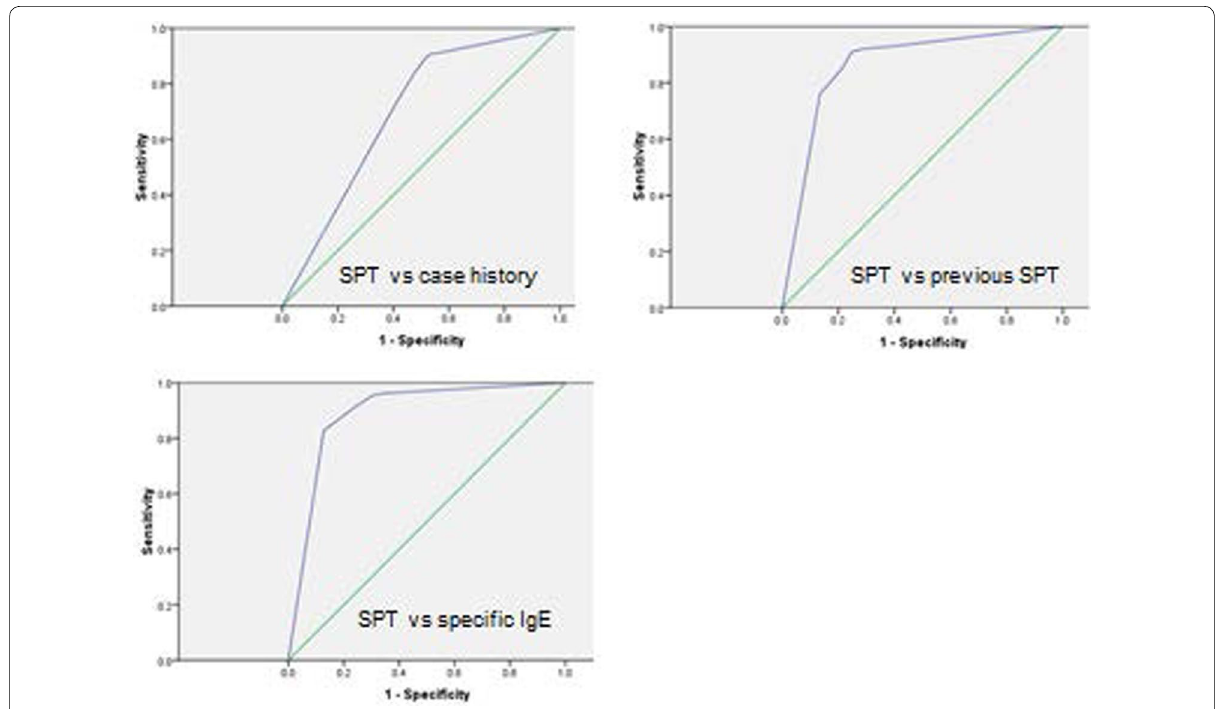
Fig. 1 ROC curve for grass SPT versus reference method